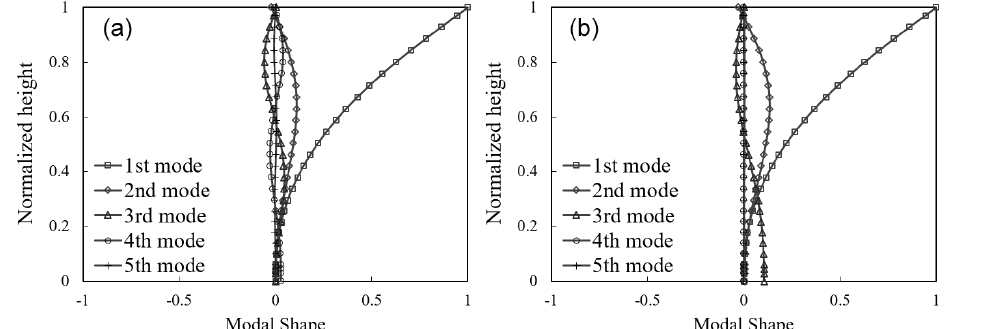
Figure 4. Real parts of complex modal participation functions: (a) Soil type I and (b) Soil type